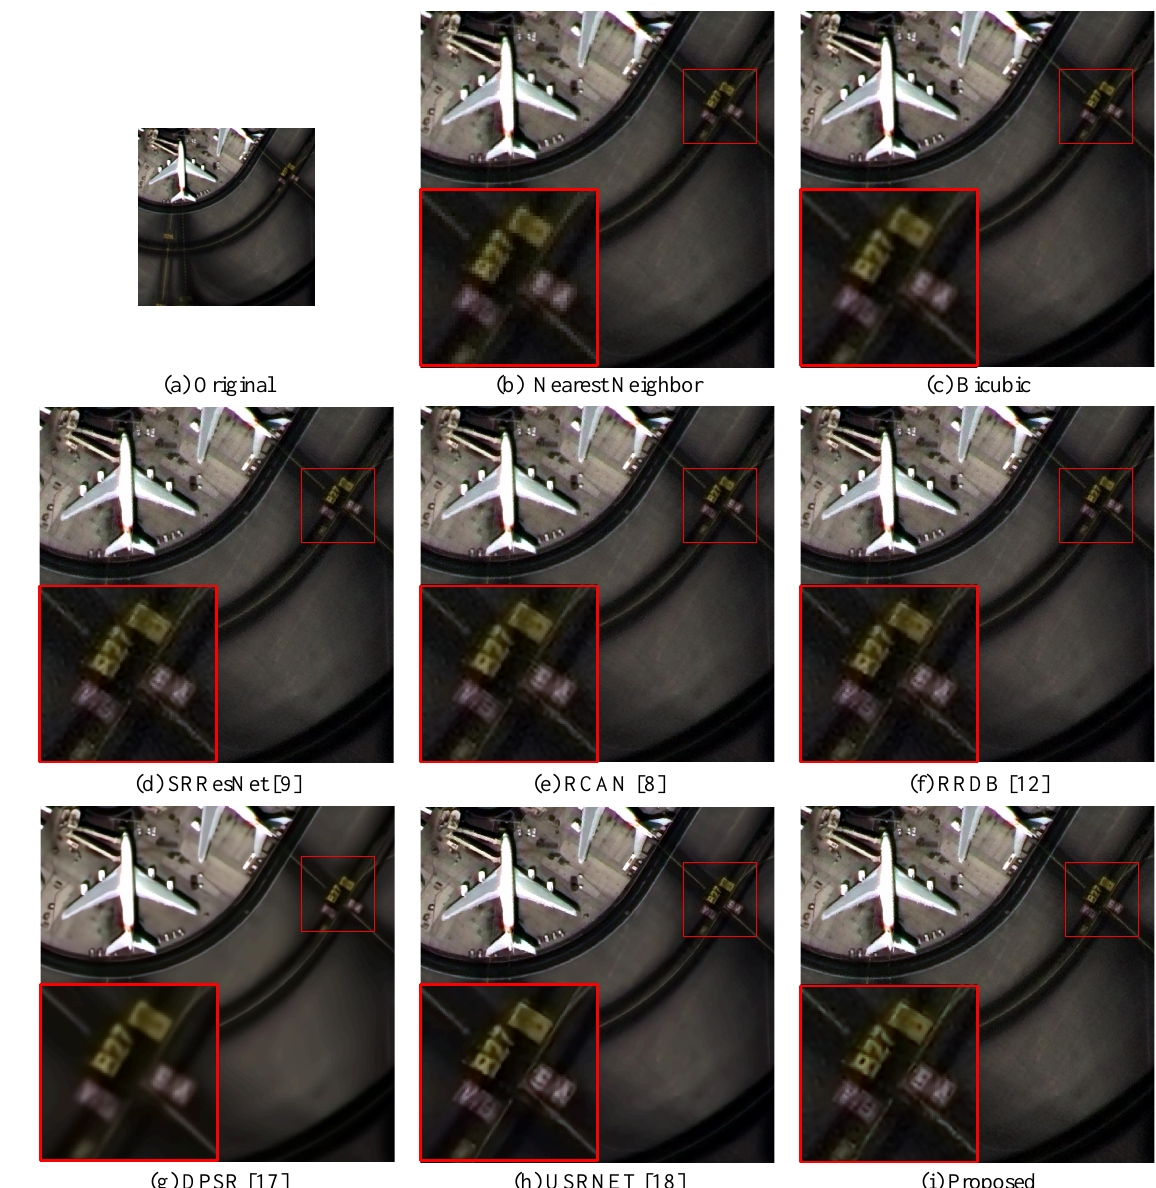
Figure 9. Visual qualitative comparisons of the proposed method with other SR methods on a pansharpened KOMPSAT-3 image, Dubai In-ternational Airport,